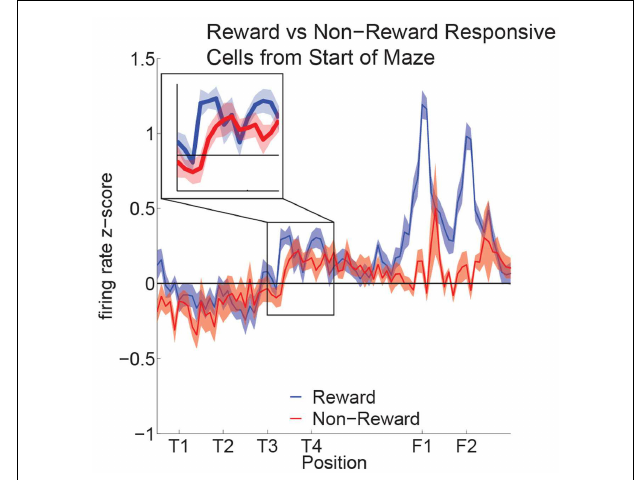
speed (36/158 cells aligned to start of the session, 57/214 cells aligned to contingency switch).The bottom row of panels (G,H) shows the average zFRate versus zIdPhi for those cells not correlated with speed (122/158 cells aligned to start of session, 157/214 cells aligned to contingency switch).The diagram on the right (I) depicts the total number of cells (black), the number of reward responsive cells (red), the number of reward responsive cells correlated with zIdPhi (blue), and finally the number of reward cells correlated with zIdPhi and speed in purple and the number of reward cells correlated with zIdPhi but not speed in orange.